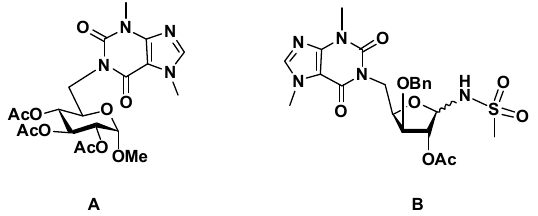
Figure 1. Terminal theobromine isonucleosides, including a glucopyranosid-6 ′ -yl derivative ( A ) and a furanos-5’-yl-based N -isonucleosidyl sulfonamide ( B ), as selective AChE inhibitors.